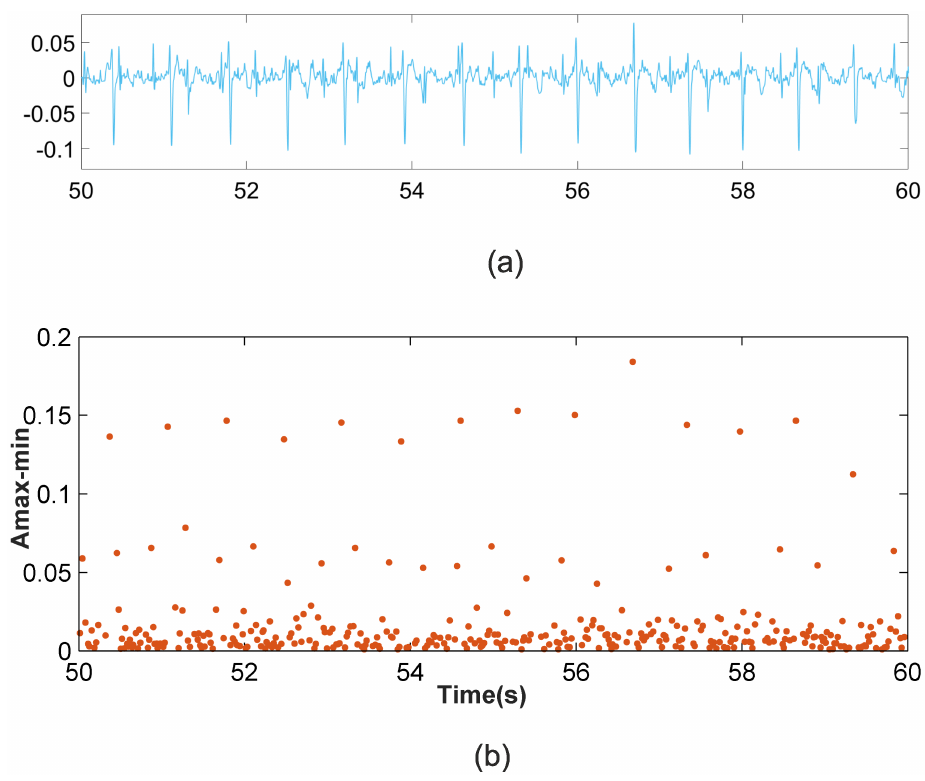
Fig 2. Scenario 1 example. (a) r08 Ab-1 preprocessed signal (b) Amplitude distance between the detected maximum followed by a minimum.